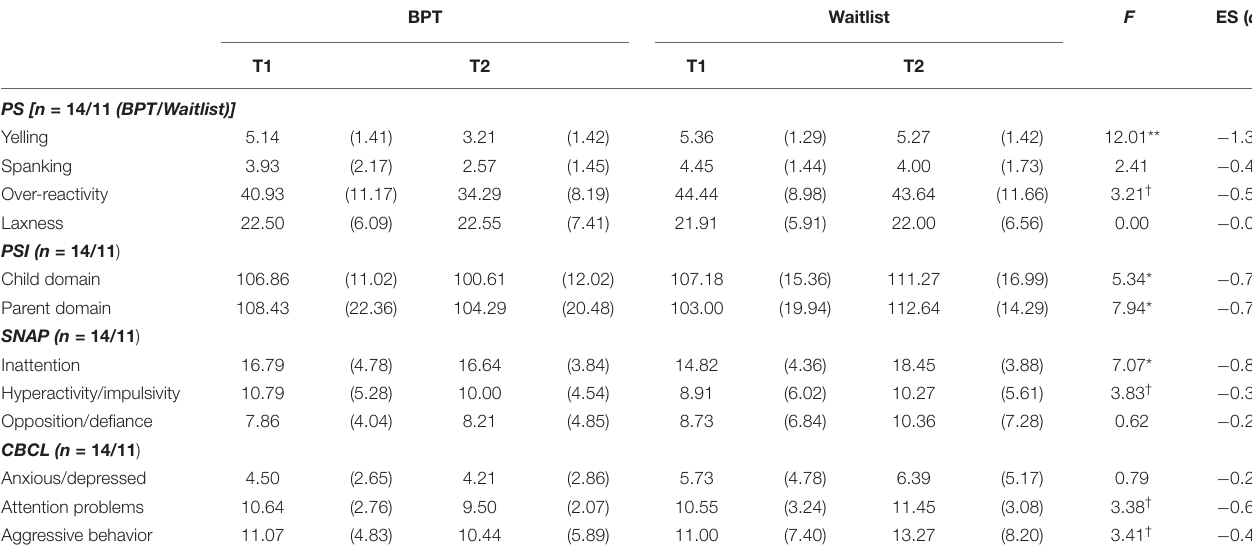
TABLE 2 | Subjective (parent-reported) questionnaire outcomes for the BPT and waitlist control